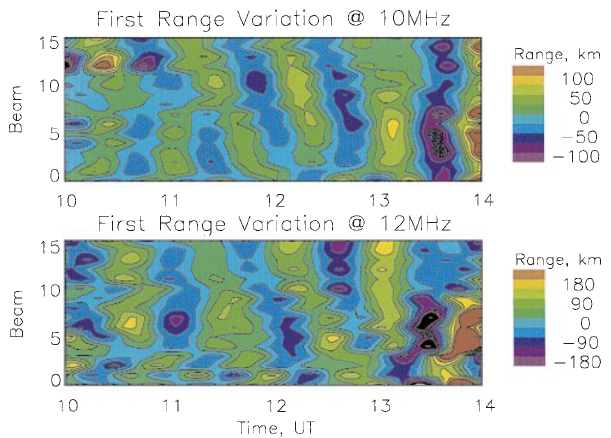
Fig. 3a, b. The skip distance variation measured for all the radar beams at frequencies of a 9.97 MHz and b